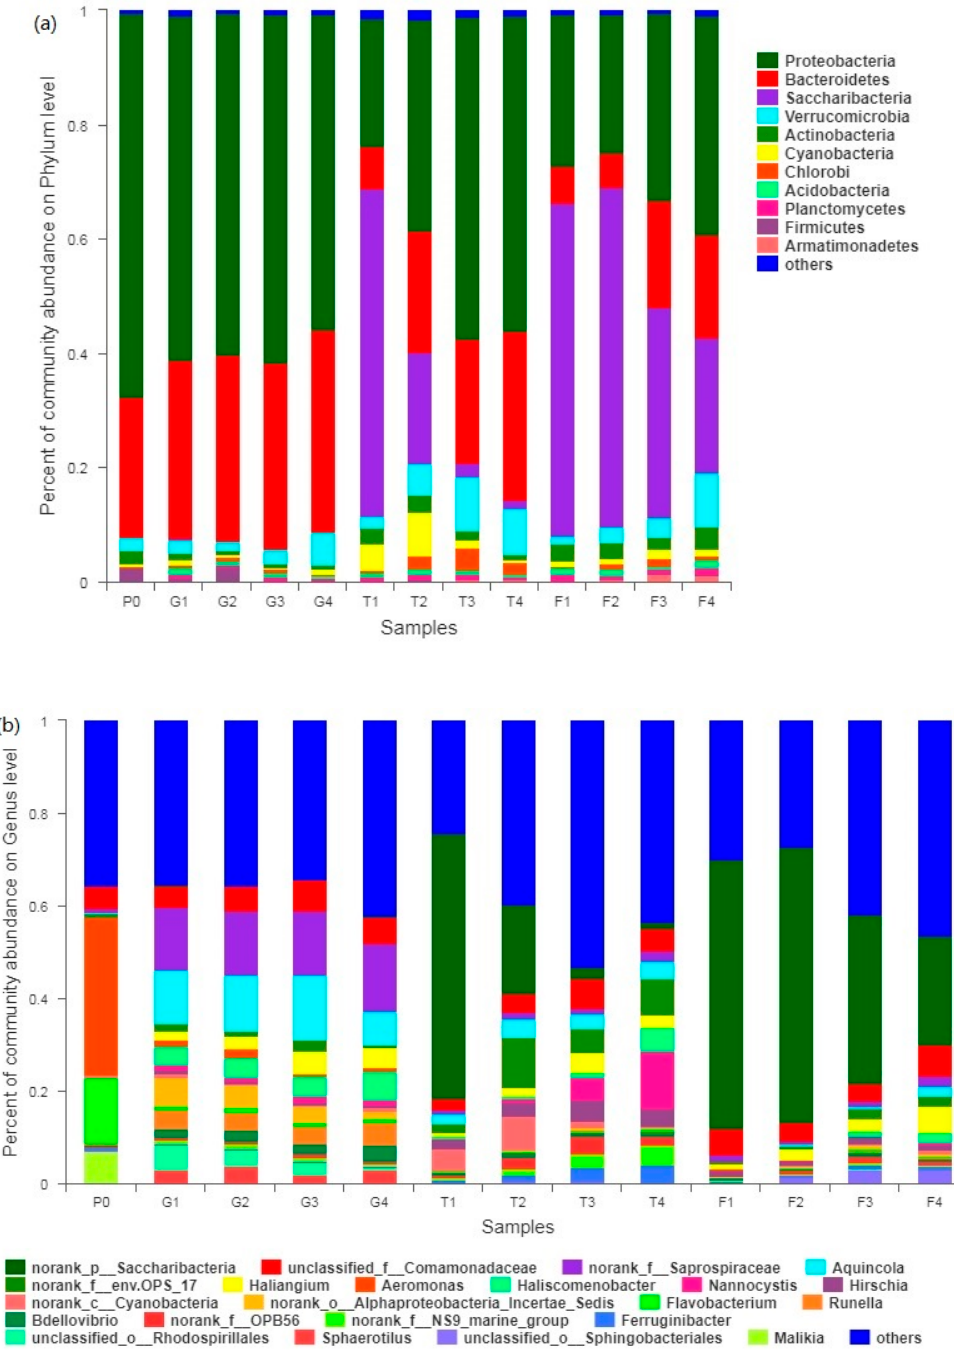
Figure 4. Bar profiling graphs of all samples (each bar shows the average of three parallel samples) at phylum ( a ) level and genus ( b ) level (dominating phyla > 1% in one sample, dominating genus > 3% in one sample). P0: day 1; G1–G4: day 9, the sequence of ordinal numbers represents treatments C / N 10, C / N 15, C / N 20 and C / N 25, respectively. Same as below; T1–T4: day 19, F1–F4: day 29.